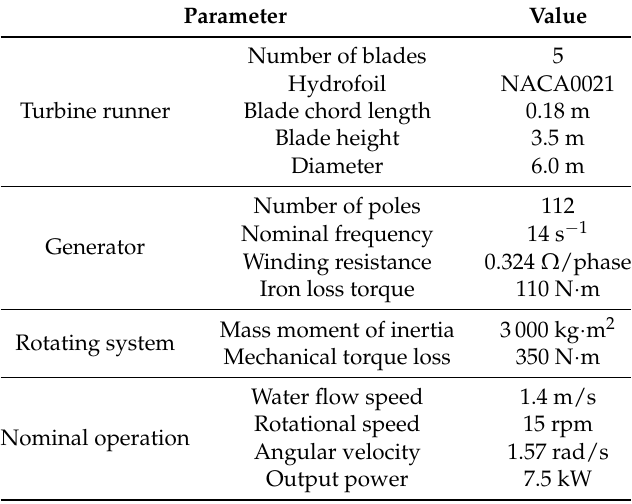
Table 1. Characteristics of the Söderfors experimental